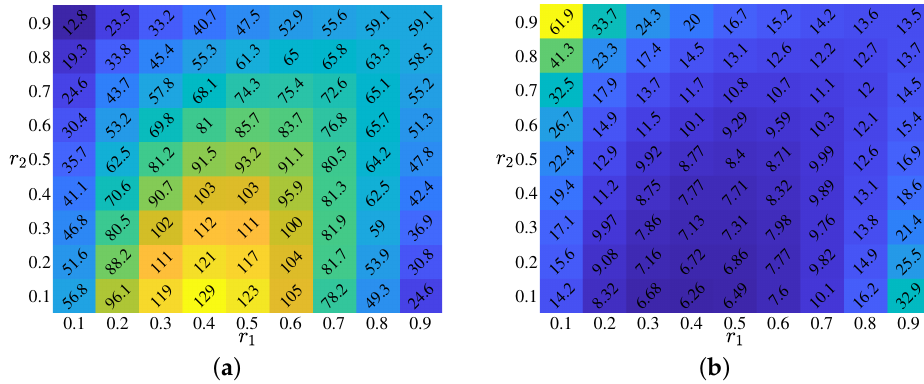
Figure 6. Effect of ratios r 1 and r 2 : ( a , b ) visualize the average number of chains and the average number of confirmed patients that make up the chain according to the combination of r 1 and r 2 ,